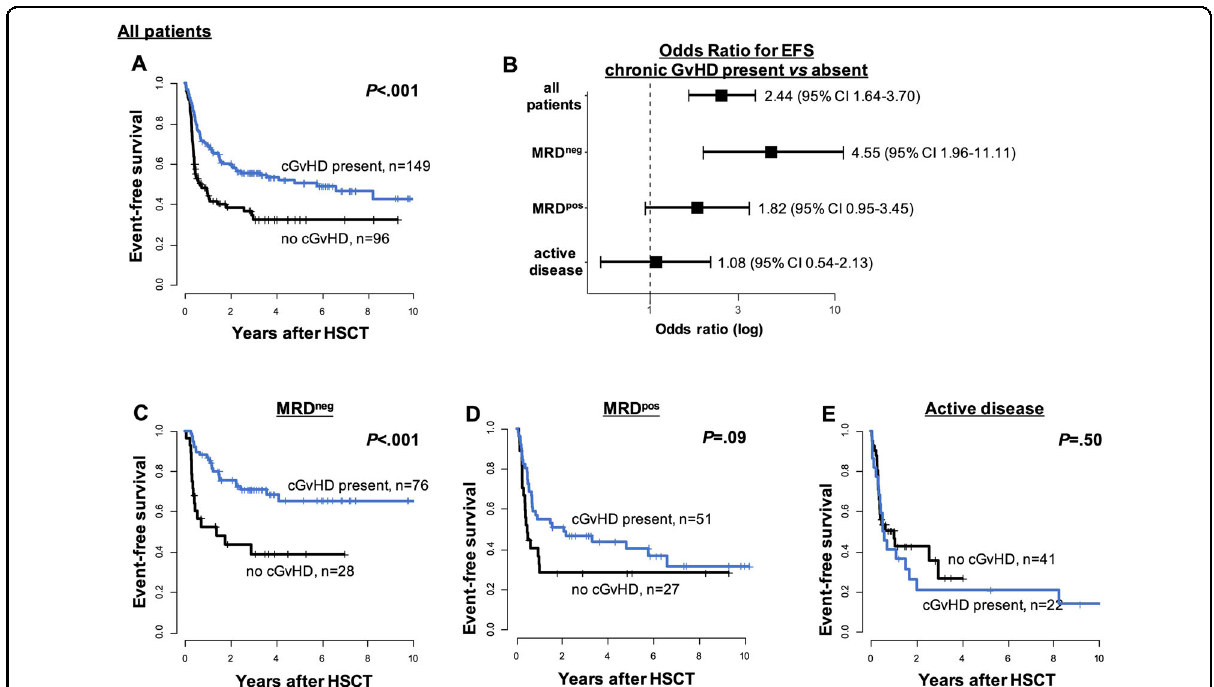
Fig. 2 Event-free survival according to the presence of a chronic GvHD in patients surviving longer than 100 days after allogeneic RIC- or NMA-HSCT (landmark analysis). A All patients ( n = 245), B forest-plot for the odds-ratio for EFS when chronic GVHD is present for all patients and for the subgroups according to the remission status, C EFS according to the presence of chronic GvHD in MRD neg patients ( n = 104), D MRD pos patients ( n = 78), and E patients with active disease ( n = 63) at